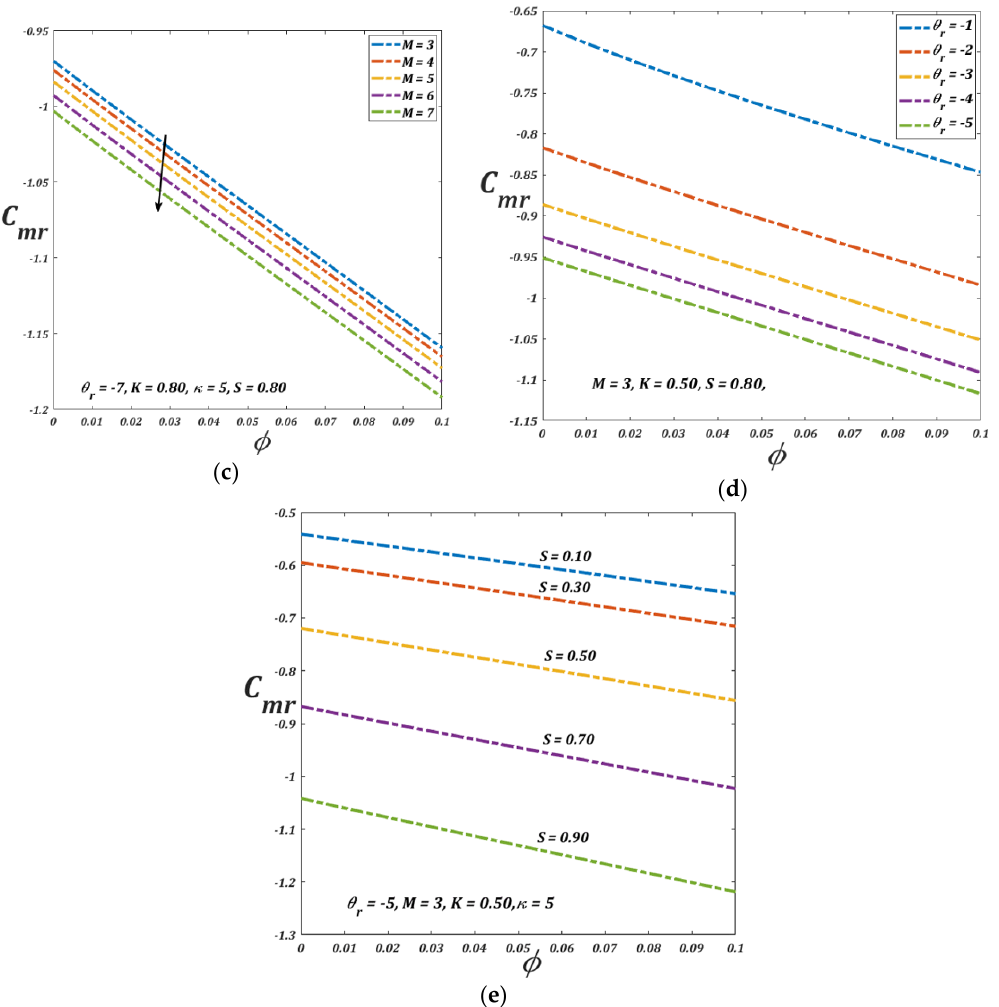
Figure 9. ( a ) Skin friction with micropolar parameter. ( b ). Couple stress coefficient with curvature Figure 9. ( a ). Skin friction with micropolar parameter. ( b ). Couple stress coe ffi cient with curvature parameter. ( c ). Couple stress coefficient with magnetic parameter. ( d ). Couple stress with variable parameter. ( c ). Couple stress coe ffi cient with magnetic parameter. ( d ). Couple stress with variable viscosity parameter. ( e ). Couple stress with porosity parameter. viscosity parameter. ( e ). Couple stress with porosity parameter. Processes 2018 , 6 , x FOR PEER REVIEW